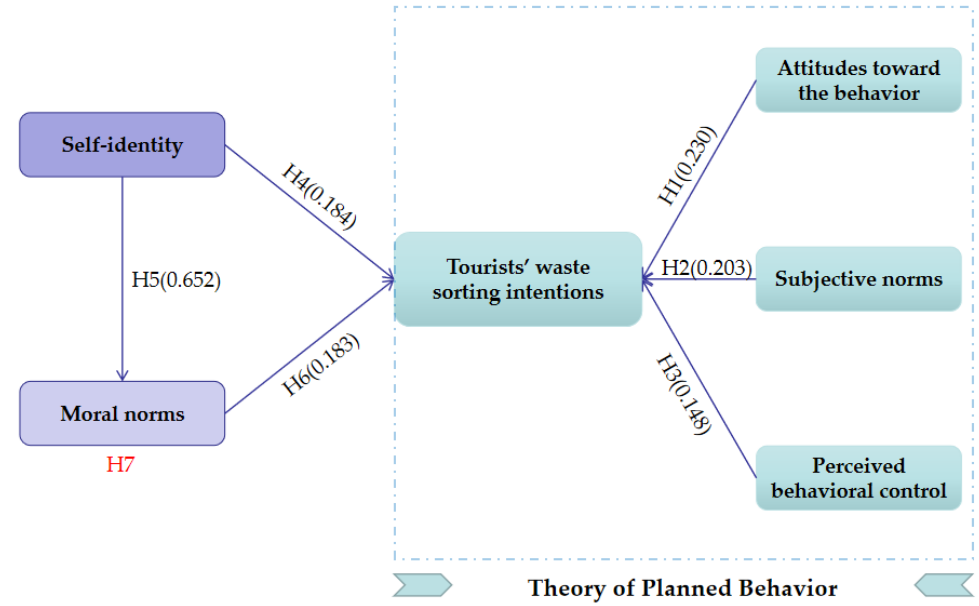
Figure 3. AMOS output results of the model in this research.